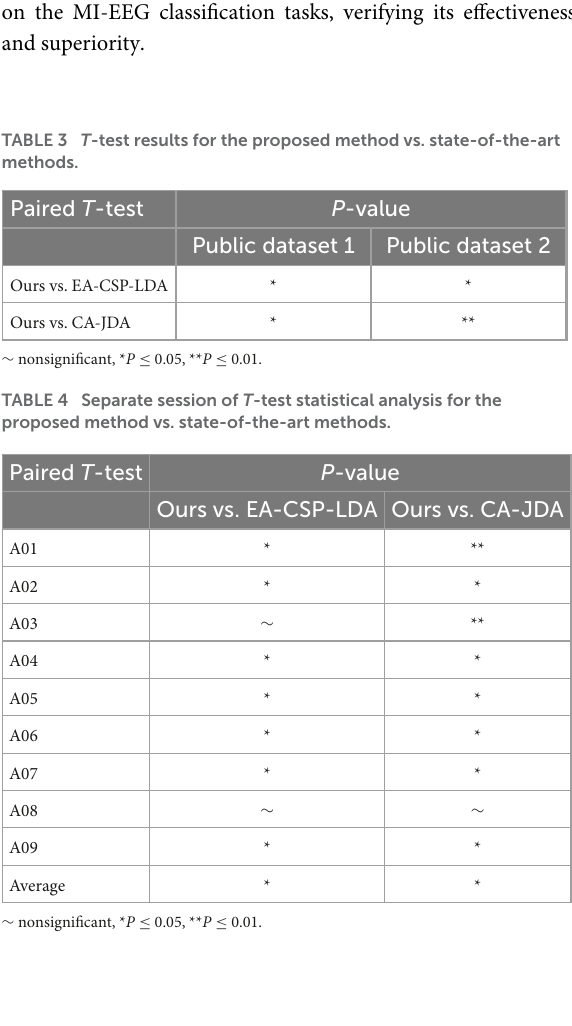
with large differences, especially for the recognition of cross-